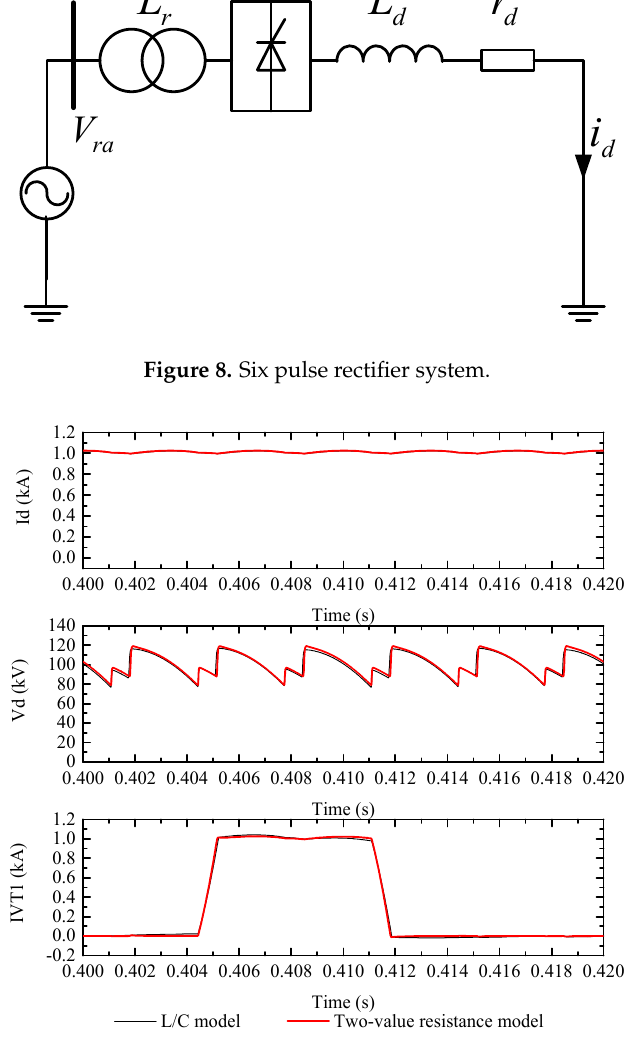
Figure 9. Steady state simulation results of six pulse rectifier system. ( Top ) DC current, ( middle ) DC voltage, ( bottom ) the current of VT1.